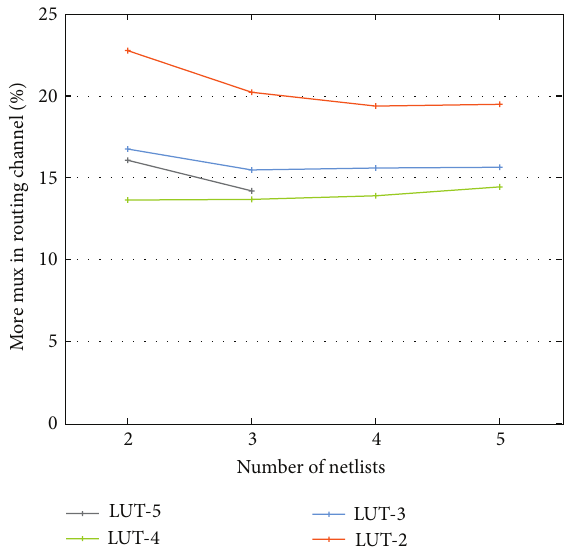
Figure 22: Multiplexer increase in routing channel after